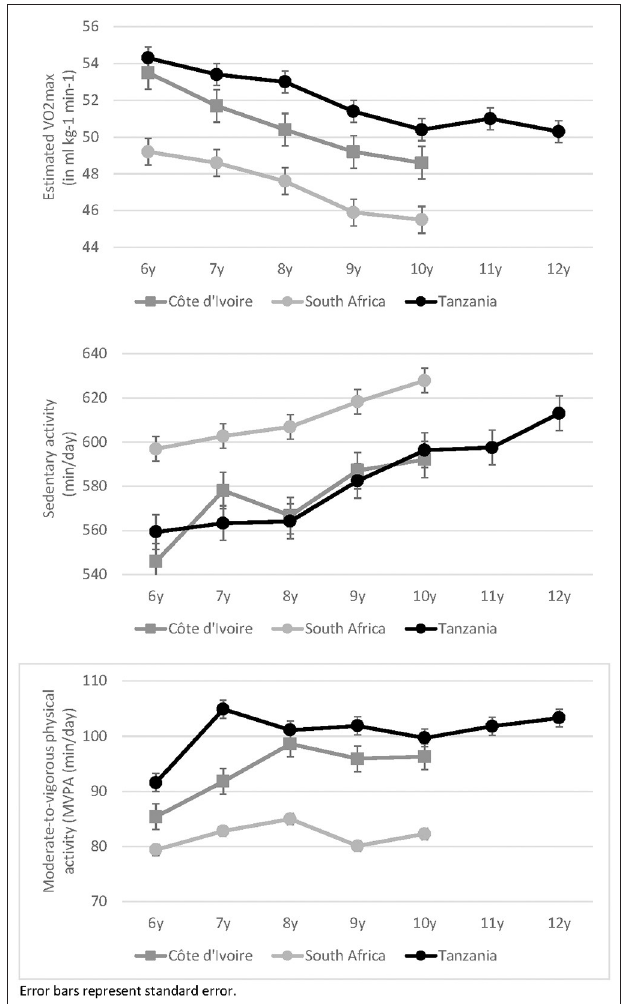
FIGURE 1 | Estimated VO 2 max and moderate-to-vigorous physical activity in children with different years of age, separately for children from Côte d’Ivoire, South Africa, and